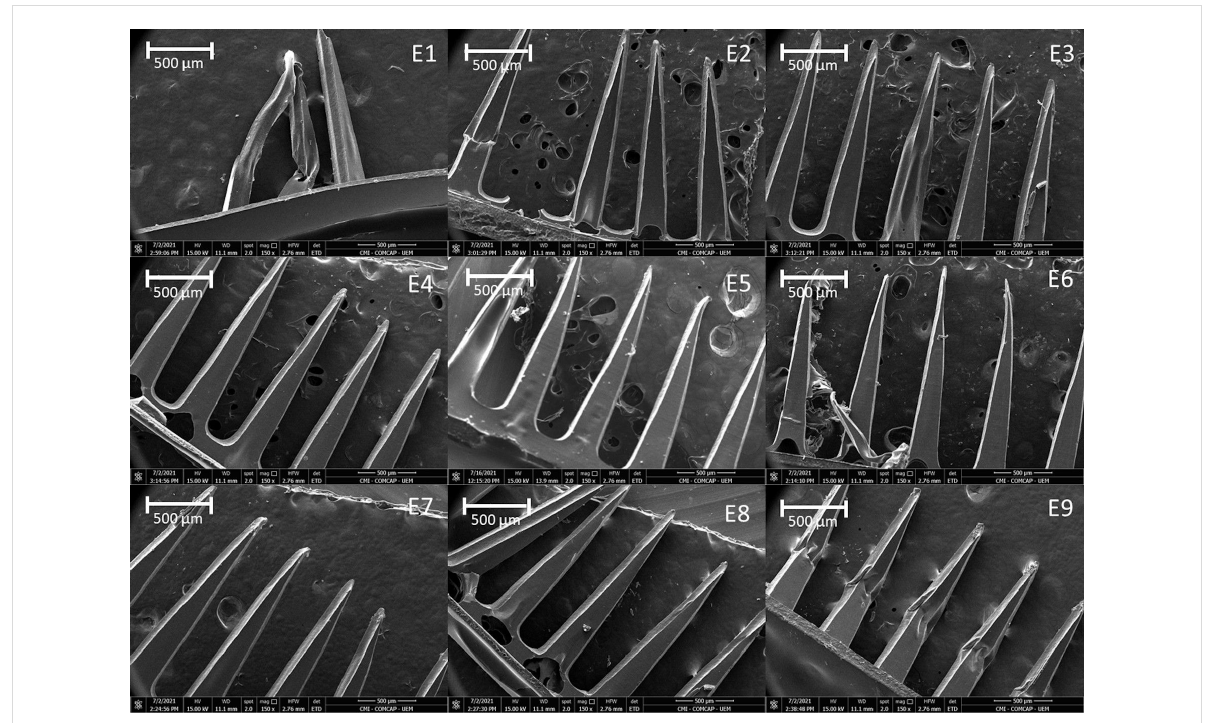
Figure 3: Micrographs obtained by scanning electron microscopy (SEM) showing the surface morphology microneedles containing ethanolic extract of propolis (E1 to E9); magnification 150×.